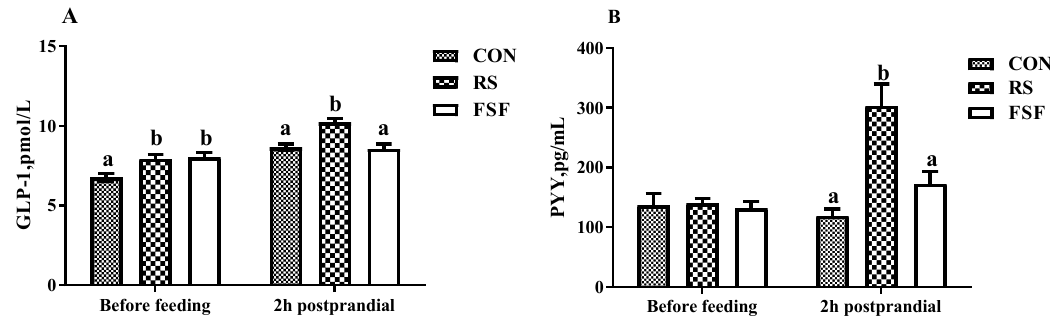
Figure 2. E ff ect of inclusion of resistant starch (RS) or fermented soybean fiber (FSF) in gestation diet on serum concentrations of sows’ GLP-1 ( A ) and PYY ( B ) on day 70 of gestation. CON = control diet group; RS = 5% resistant starch diet group; FSF = 5% fermented soybean fiber diet group. Values are means ± SEM ( n = 7–8). a,b Means with di ff erent superscript letters within a row di ff er significantly ( p < 0.05).